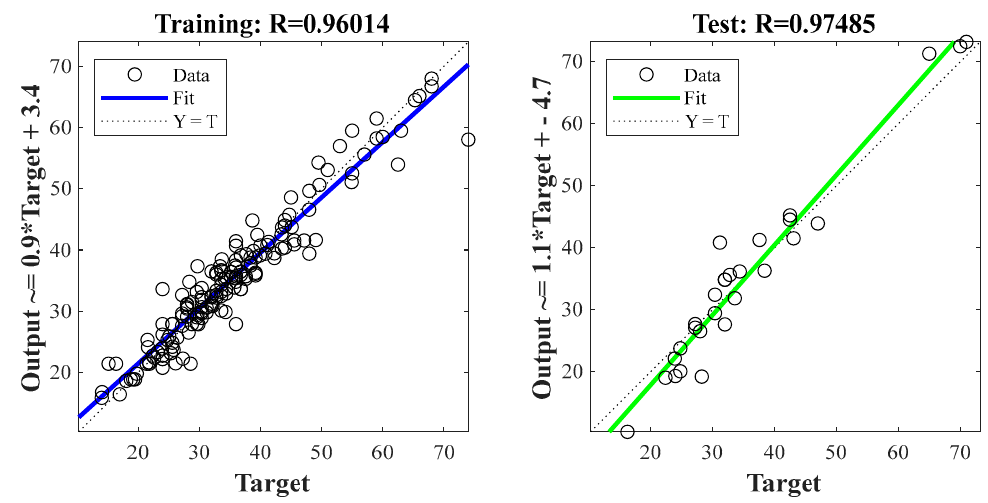
Figure 6. The correlation coefficient (R) of the training and testing subsets for the optimal model. Since the RMSE value was ±3.87 MPa for the testing data (data that were unseen in the training process), the optimal model could be generalised for future data with an average error of ±3.87 MPa. Figure 7 demonstrates that the error of the optimal model is normally distributed, and most of the data have an error value equal to or less than the RMSE (±3.87 MPa). Since the RMSE follows a normal distribution, the probability can be calculated from the Gaussian probability tables [25]. By applying the z probability table, for z = ±3.87, the corresponding probability value is 99.995%. This means that the probability of the optimal model would be 99.995% in the [ − 3.87, 3.87] interval for future data. Therefore, the performance of the optimal model is excellent compared with the results of other machine learning methods in the peer-reviewed literature.